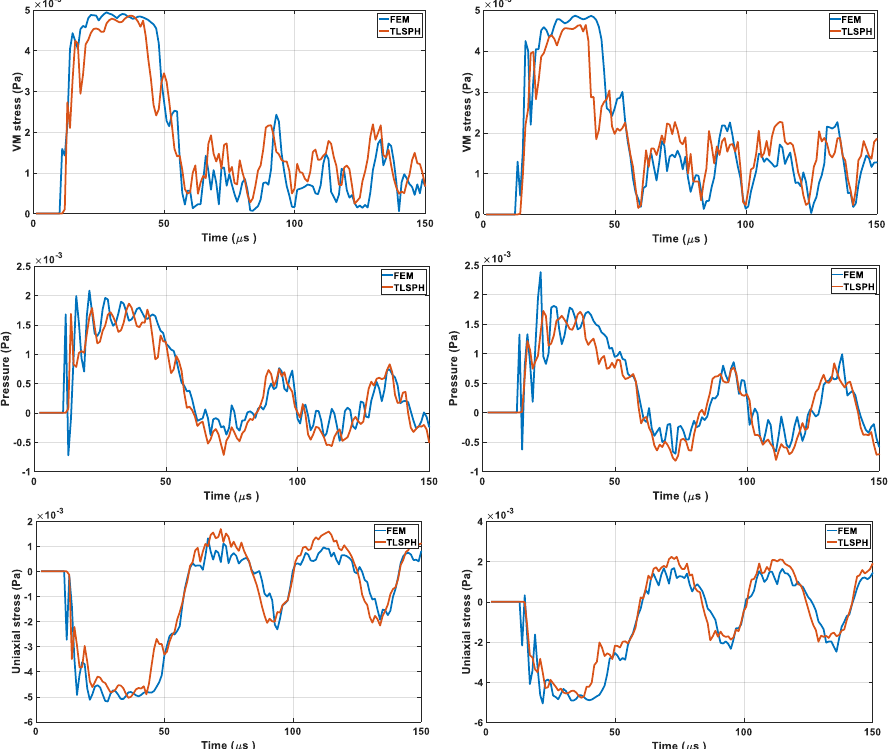
Fig. 5. Comparison of numerical Von Mises stress, pressure and uniaxial stress evolutions for FEM (blue curve) and TLSPH (red curve) at 7.75 and 12.2 mm from the impact surface; impact velocity of 73